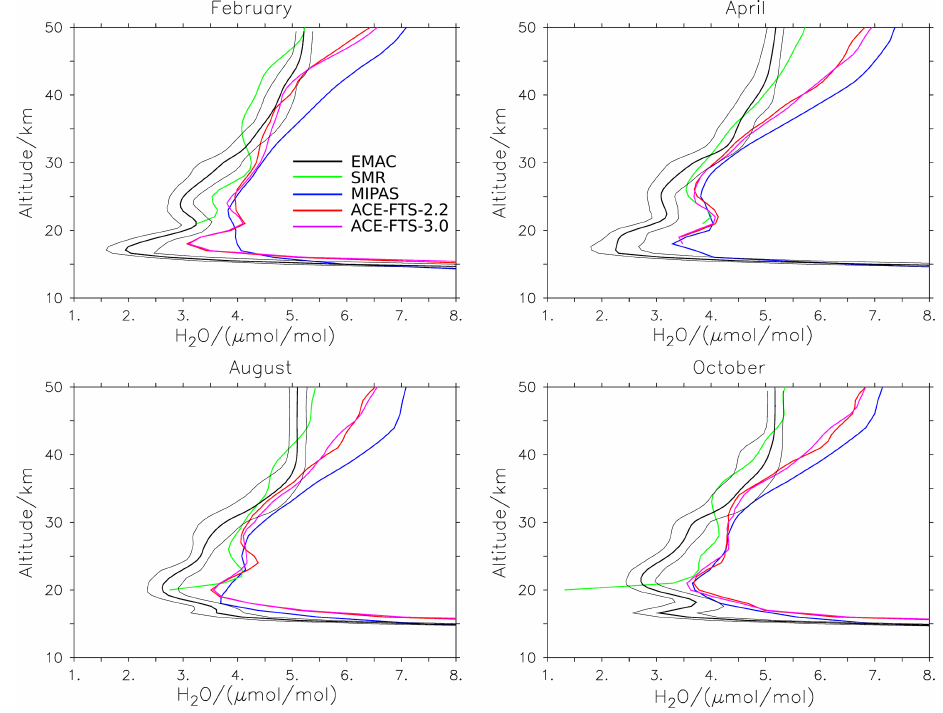
Figure 5. Comparison of H 2 O mixing ratio–altitude profiles between EMAC and various satellite observations. Black: averages, minima and maxima of 21 monthly averages of the EMAC simulation for the respective months; green: Odin/SMR; blue: ENVISAT/MIPAS; red: SCISAT/ACE-FTS-2.2; purple: